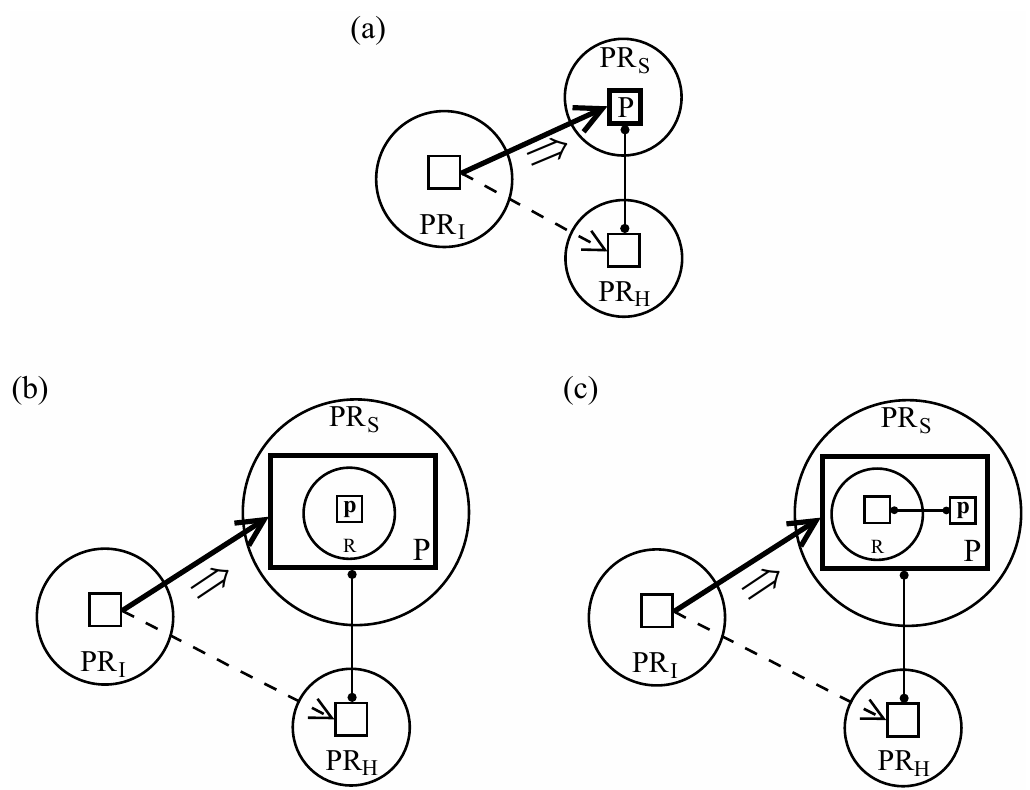
Figure 11. Propositional reality and polarity focusing.